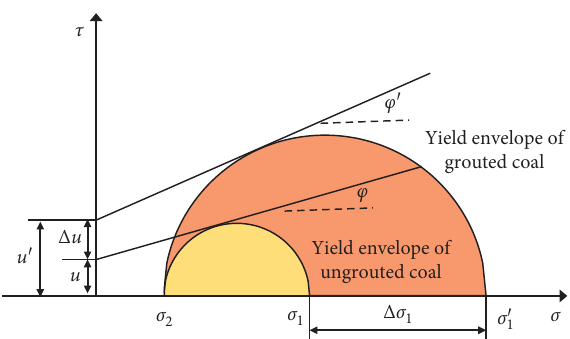
Figure 4: Comparison of mechanical properties of coal before and after